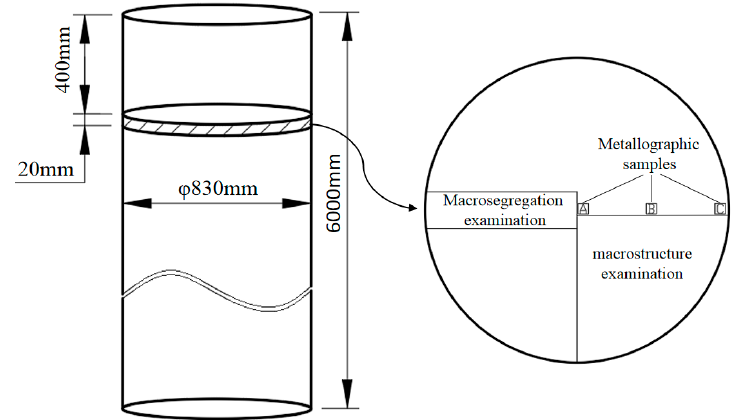
Figure 3. Sampling locations of ingot samples.